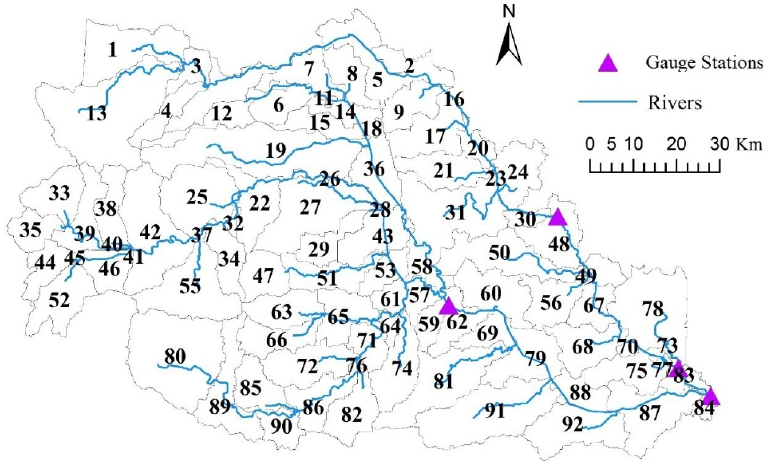
Figure 7. 92 sub-basins and the main streams contained in the Hong–Ru River Basin based on ArcGIS.